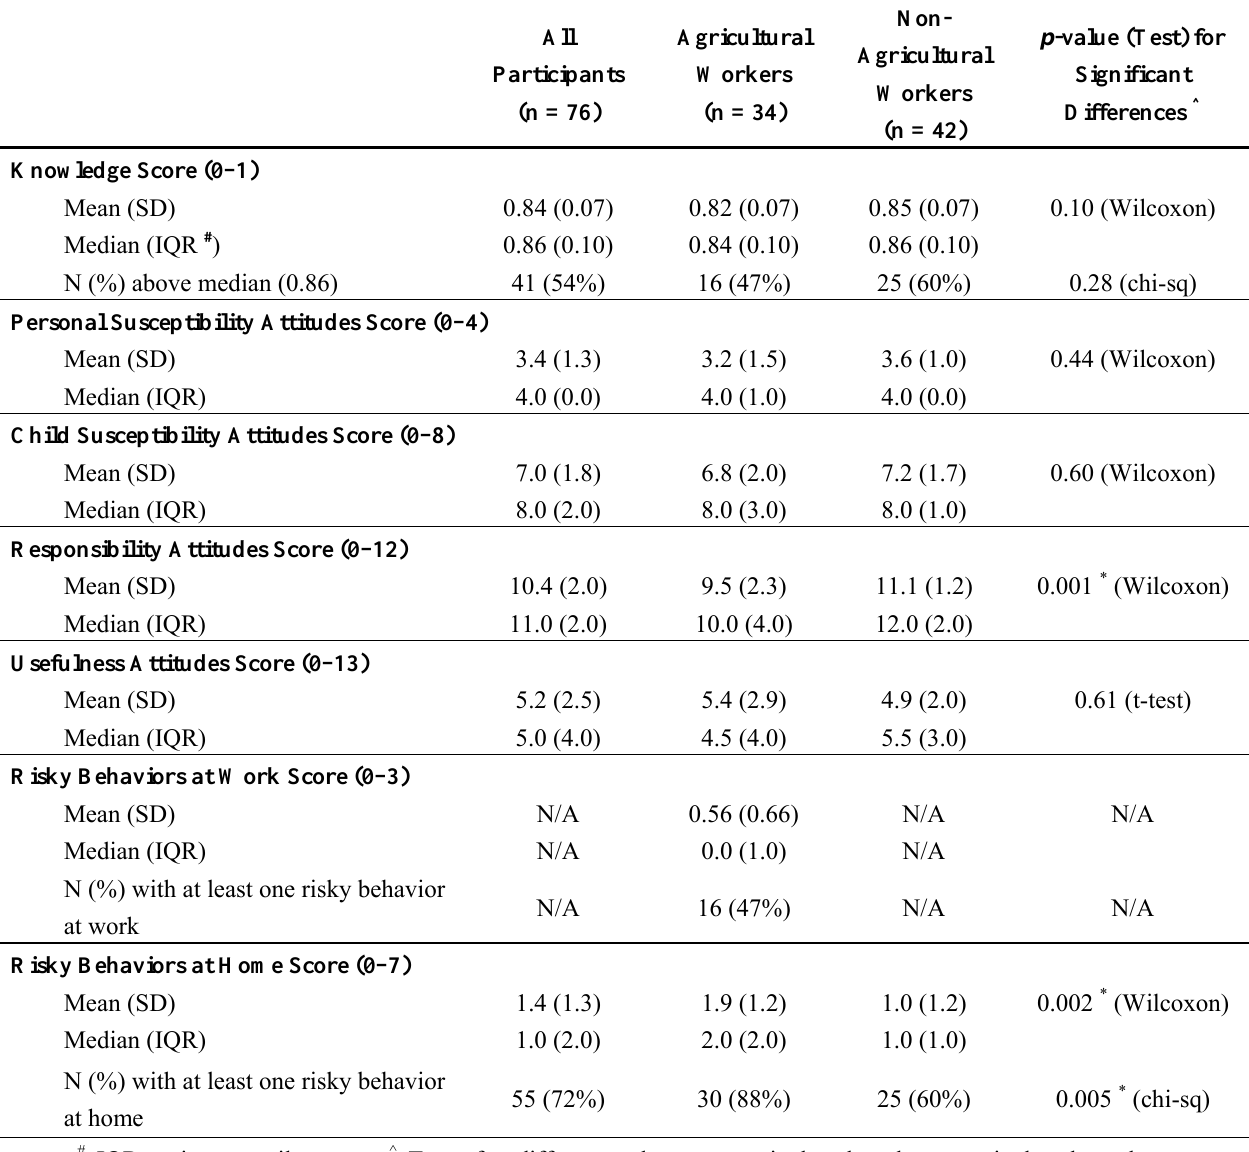
Table 3. KAP scores of all participants and by